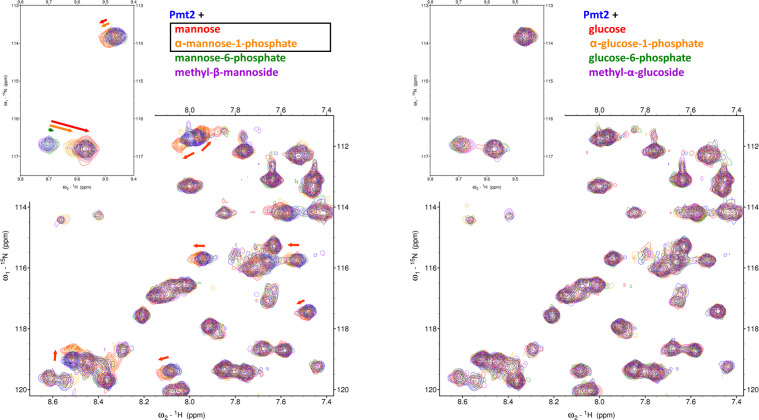
NMR screening of Pmt2-MIR sugar interactions.Pmt2-MIR spectra with several sugars are shown: mannose and derivatives (left) and glucose and derivatives (right). The presented regions from 1H15N-HSQC spectra after addition of 55-times excess of the sugar (10 mM) are overlaid on top of the spectrum of apo-Pmt2-MIR (in blue). The evident CSPs for several Pmt2 amide signals show a specific (and comparable) interaction for mannose (left, in red) and α-mannose-1-phosphate (left, in orange), while the other sugars do not affect the spectrum of Pmt2-MIR.